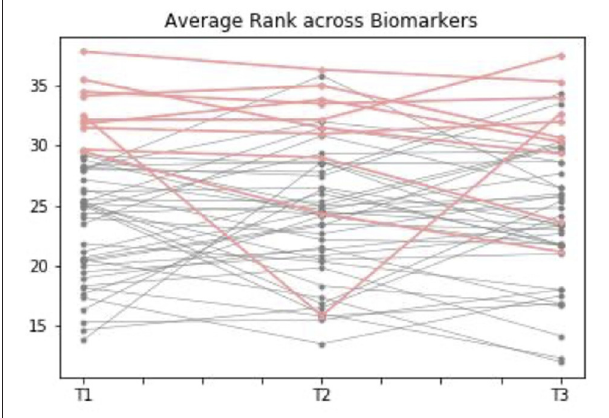
FIGURE 4 | Average comparative rank of vitamin B 12 biomarker status during the three trimesters of pregnancy. This graph shows how individuals with complete data points available for biomarkers of vitamin B 12 [including transcobalamin (holoTC), serum folate (Folate), serum B 12 , homocysteine (tHCy), methylmalonic acid (MMA), and cB 12 ] rank across the three trimesters. Ranking was calculated according to a set of statistical rules: it was considered “better” to have high folate, sB12, cB12 and holoTC, but low MMA / tHcy, where 1 is “more sufficient” and 50 + is “more insufficient.” The average of biomarker ranks for each individual was calculated at each trimester. When the “most insufficient” 10 individuals (marked in the graph as red) were plotted in Trimester 1 [T1], 7 of these remained in the lowest group at Trimester 2 [T2] and Trimester 3 [T3], suggesting there might be a subgroup at risk of insufficiency based on first trimester measurements.